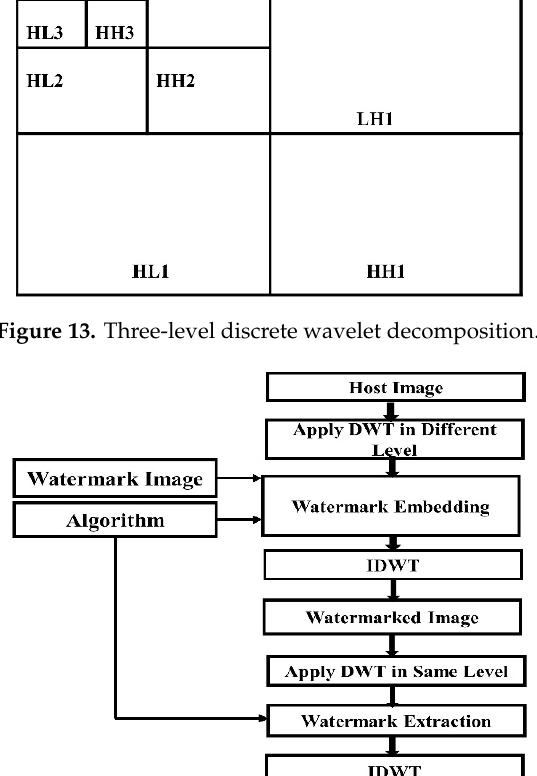
Figure 13. Three-level discrete wavelet decomposition.